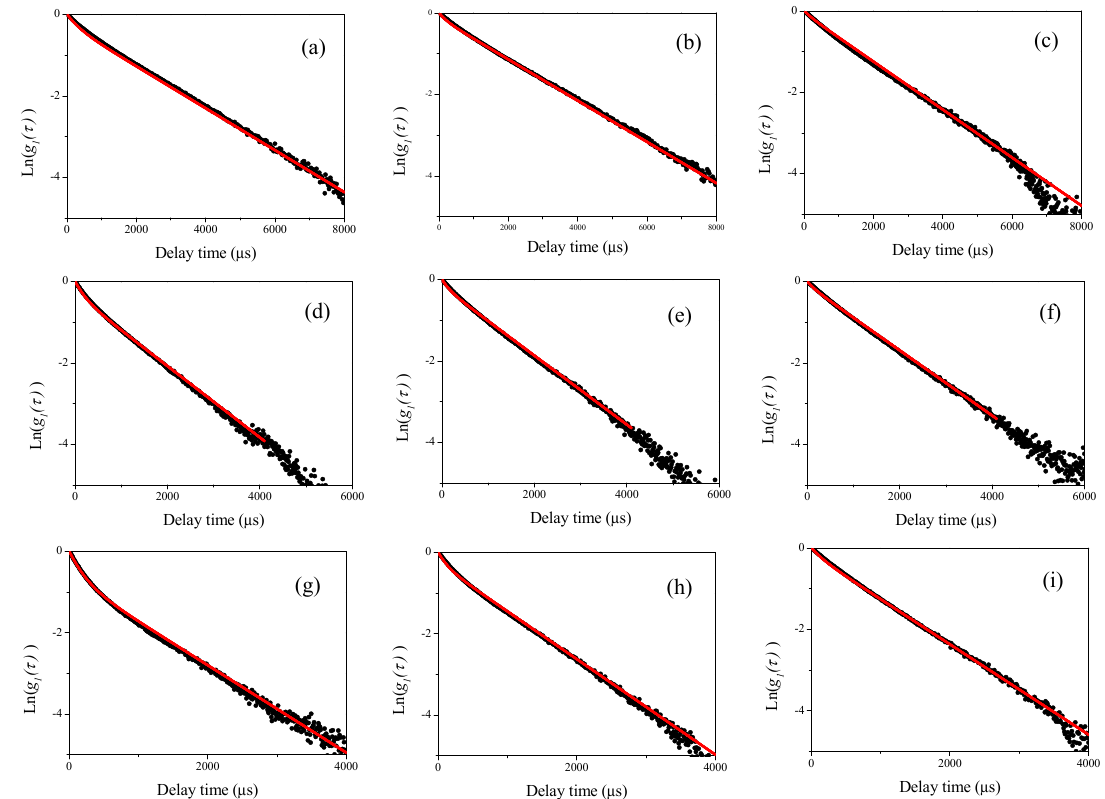
Figure 9. Observed homodyne photon correlation functions (black dots) vs. calculated homodyne photon correlation function curve using equation 1 and 2 (red solid curves) for the results shown in Figure 6c,d. ( a ) 70-500-1 at a detector angle of 90°; ( b ) 70-500-2 at a detector angle of 90°; ( c ) 70-500-3 at a detector angle of 90°; ( d ) 70-500-1 at a detector angle of 120°; ( e ) 70-500-2 at a detector angle of 120°; ( f ) 70-500-3 at a detector angle of 120°; ( g ) 70-500-1 at a detector angle of 150°; ( h ) 70-500-2 at a detector angle of 150°; and ( i ) 70-500-3 at a detector angle of 150°.